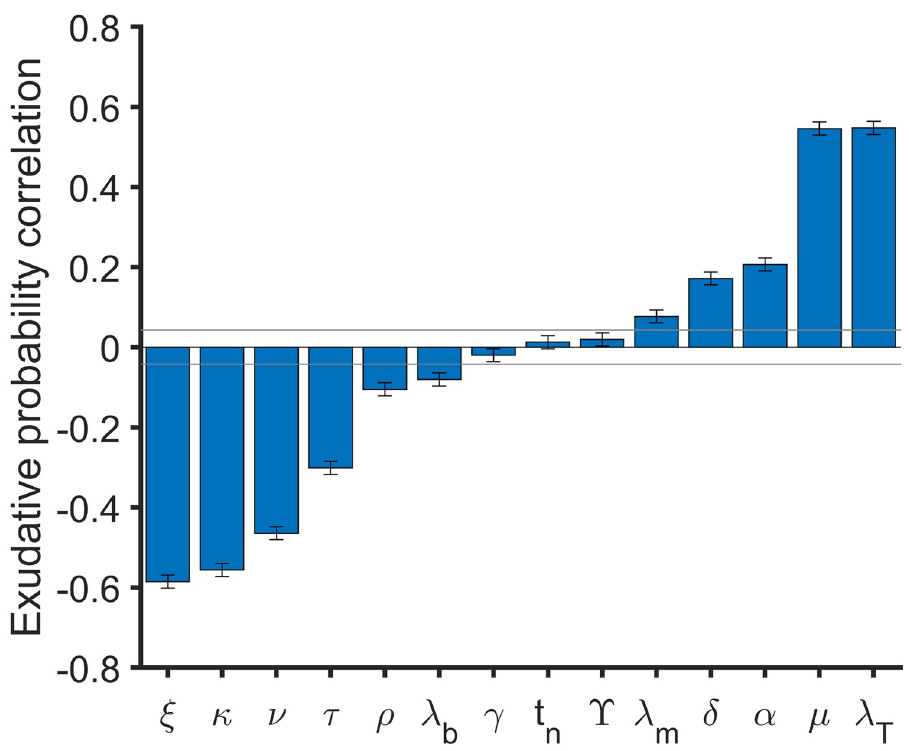
Fig 5. Partial Rank Correlation Coefficient (PRCC) between input parameters and exudative probability. PRCC between ξ , κ , ν , λ b , γ , t n , Y , λ m , δ , α , τ m and λ T and exudative probability are shown in blue bars. Infection probability is computed at time = 200 day as the presence or not of bacilli ( b mark significance threshold for PRCC values using a significance level of 0.05. A total of 1500 parameters sets are used to explore the parameter space defined in Table 1 using Latin Hypercube Sample technique. For each set of parameters a total of 10000 simulations are done. Error bars are computed as the standard error of Spearman’s correlation